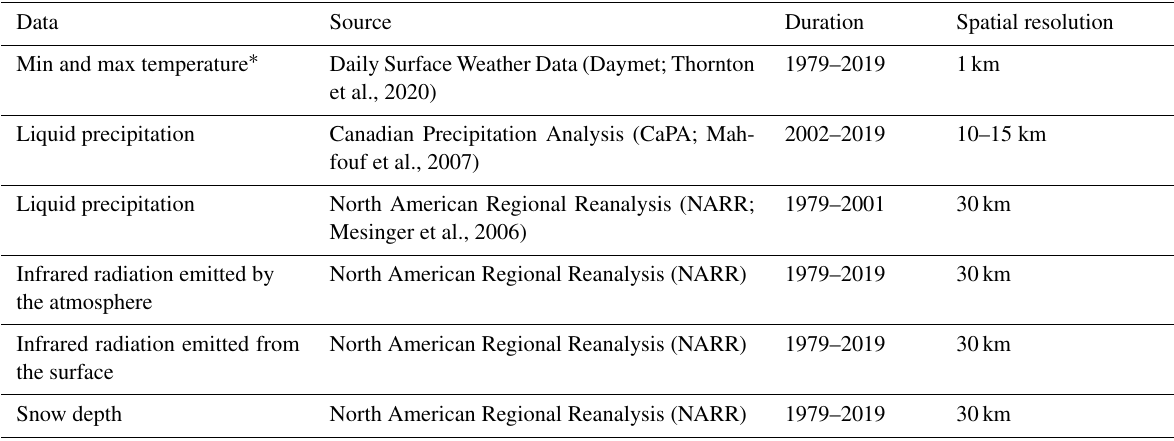
Table 2. Source, duration, and spatial resolution of hydro-meteorological data used in the models. Data Source